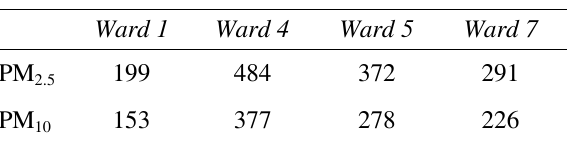
Table 3: Comparisons of Estimated Excess Cases for Pediatric Asthma ERV for Fall IOP Fall